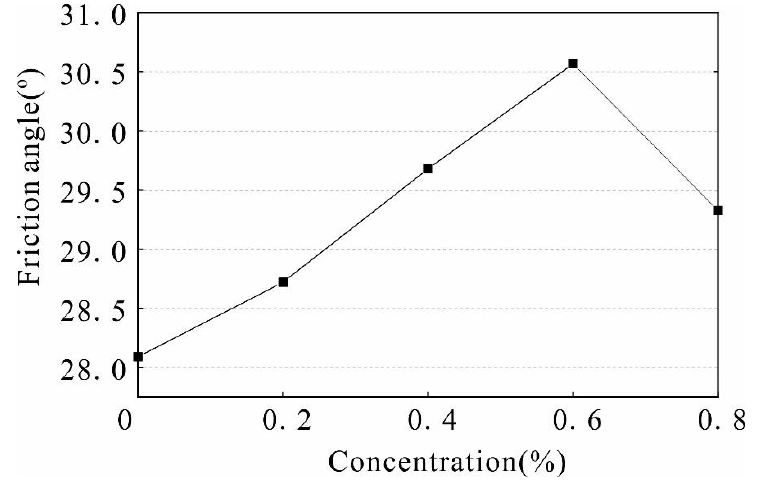
Figure 10. Internal friction angle curve under different stabilizer concentrations.